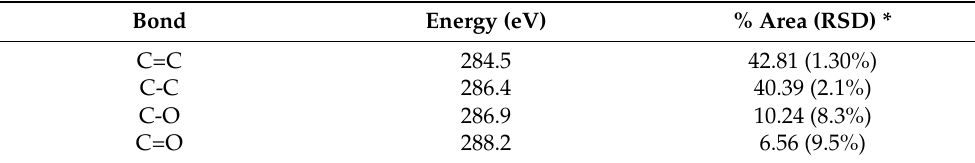
Table 1. XPS-obtained distributions for the synthetized GO for the C 1s spectra.